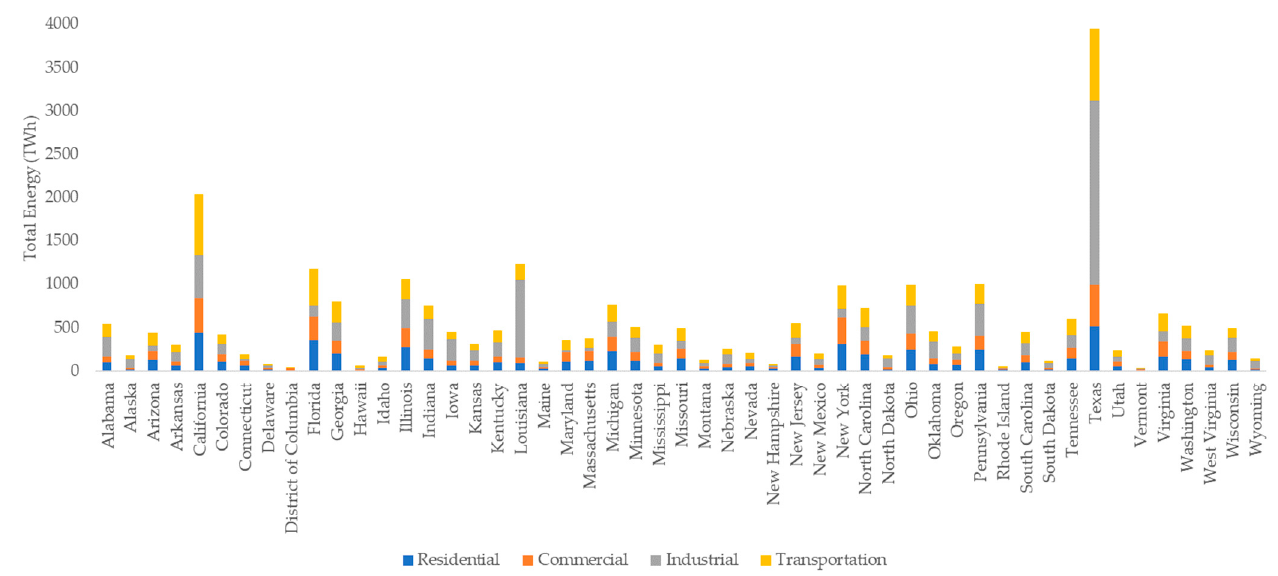
Figure 8. Total energy for each state in 2020 by sector [30].